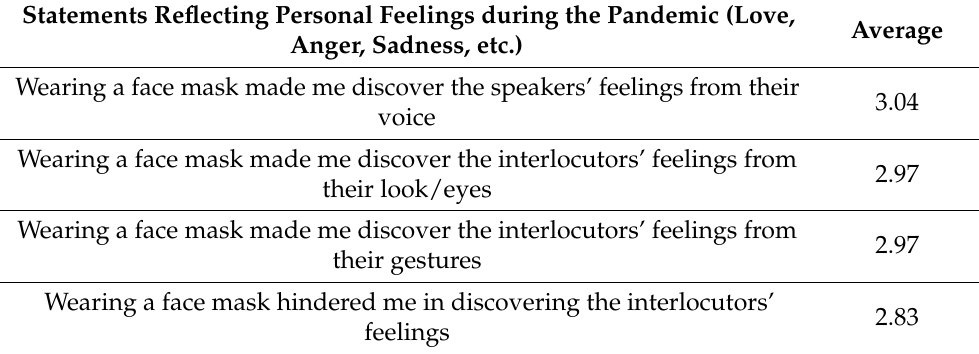
Table 4. Statements reflecting personal feelings during the pandemic.